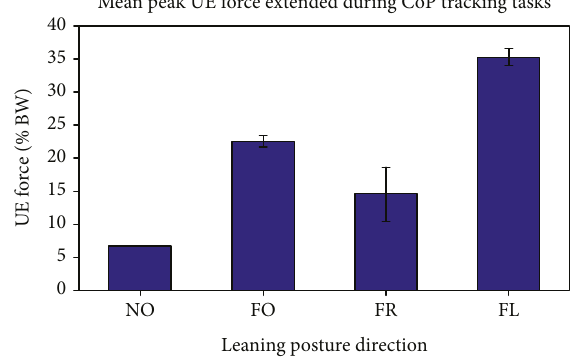
Figure 6: Mean maximum resultant UE force during leaning movements in the forward (FO), forward-right (FR), and forward- left (FL) directions. As a reference, the maximum resultant UE force exerted while the subject stood in the nominal (NO) starting position during a static trial is also displayed. Error bars are included to indicate ± 1 standard deviation of measurements across twelve